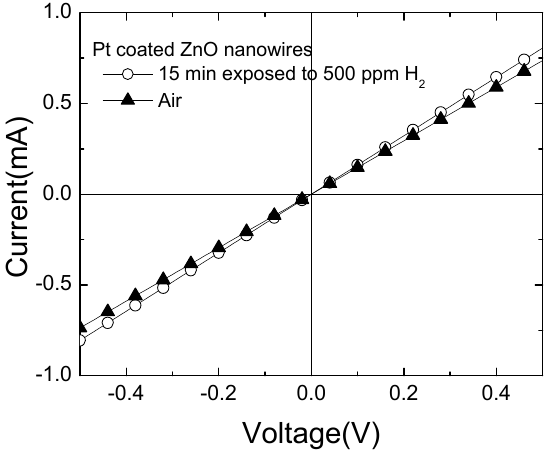
Figure 7. I-V characteristic of Pt-coated nanowires in air and after 15 mins in 500 ppm H in